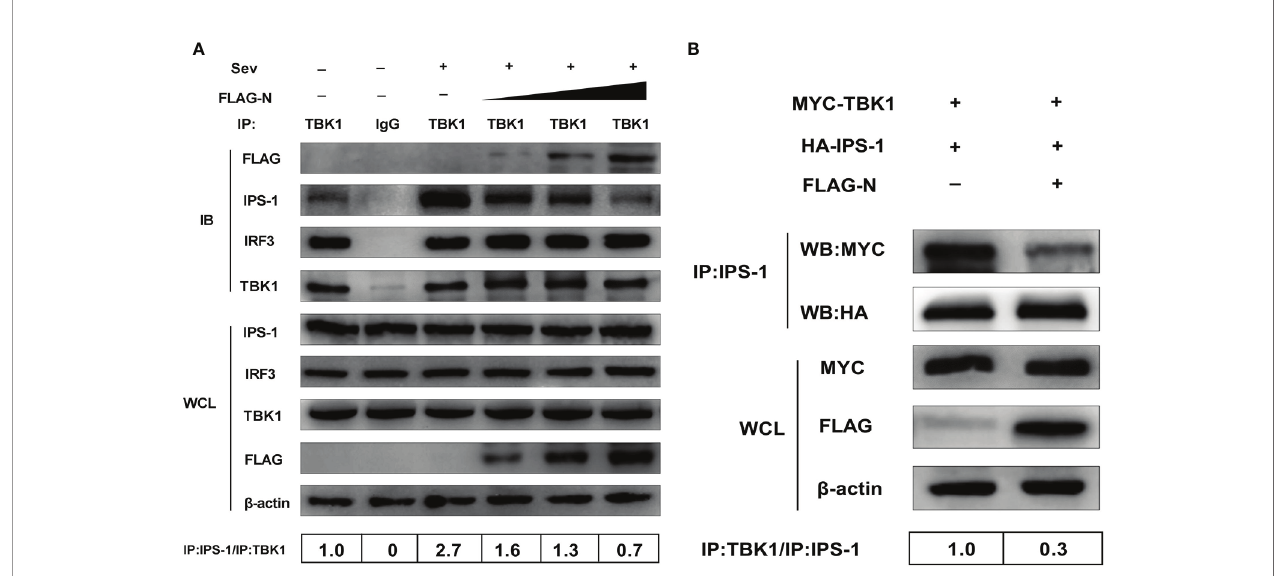
FIGURE 5 | SADS-CoV N protein disrupts the interaction between IPS-1 and TBK1. (A) HEK-293T cells were transfected with increasing quantities of plasmids pCMV-FLAG-N or mock-transfected for 24 h, and the cells were treated with Sev for an additional 12 h. The whole-cell lysates were collected and immunoprecipitated with the protein A/G magnetic beads containing the anti-TBK1 antibody or normal rabbit IgG. (B) HEK-293T cells were co-transfected with expression plasmids MYC-TBK1 and HA-IPS-1 and pCMV-FLAG-N or empty vector for 28 h. The whole-cell lysates were collected and immunoprecipitated with the protein A/G magnetic beads containing anti-IPS-1 antibody. Then protein expression levels were analyzed by Western blot with anti-FLAG, anti-MYC, anti-HA, anti- IPS-1, anti-TBK1, anti-IRF3, and anti- b -actin monoclonal antibodies (MAbs), respectively. Levels of IPS-1 or TBK1 after immunoprecipitation were quantitated densitometrically and corrected with TBK1 or IPS-1 levels in immunoprecipitation, and the ratio between the immunoprecipitated and co-immunoprecipitated proteins in untreated cells was set as